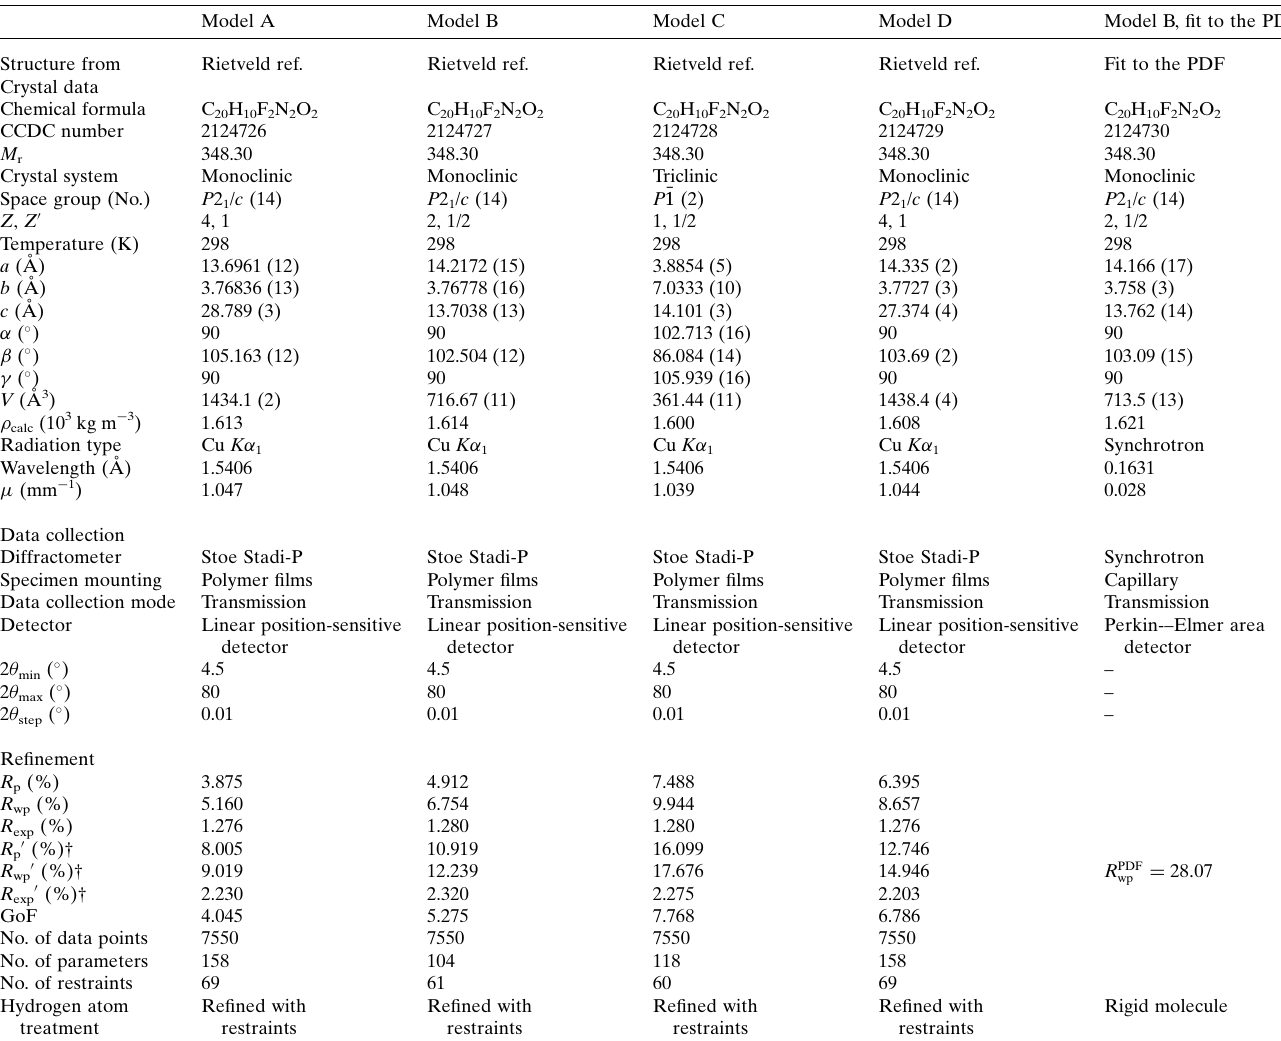
Table 3 Final crystallographic data of the four structural models A–D of DFQ from the Rietveld refinement. The last column provides the data of model B from the fit to the PDF at 298 K using a rigid molecule Model A Structure from Rietveld ref.